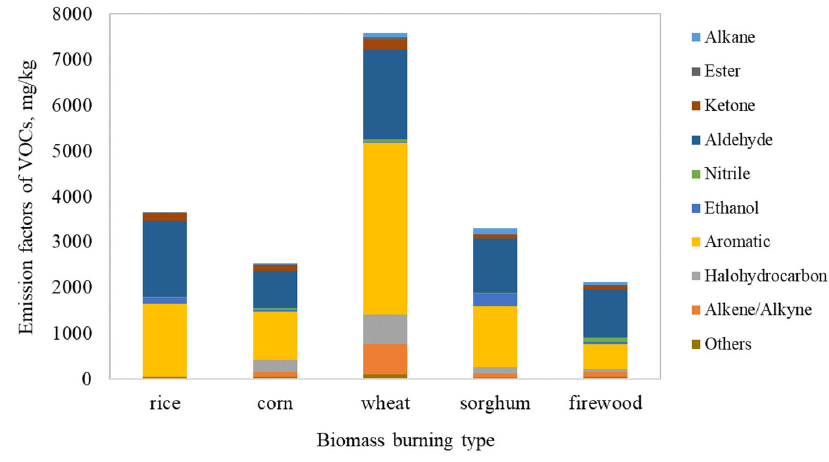
Figure 5. Emission factors of VOCs from different types of biomass.